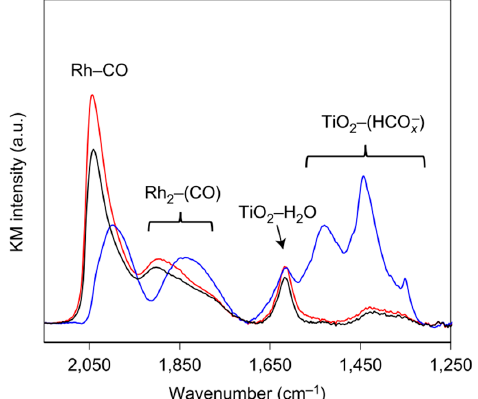
Figure 2. In situ DRIFT spectra collected from 2% Rh / TiO 2 at the reaction conditions (180 ◦ C, 1% CO 2 , 1% H 2 , 98 % He) for reduced ( red ), 20CO 2 :2H 2 treated ( blue ), re-reduce ( black ) catalysts. On 20CO 2 :2H 2 treatment, the CO stretching frequency of linear and bridge Rh-carbonyl groups decreased by 50 cm − 1 , their intensity dropped twofold and TiO 2 -bound HCO x species appeared. Re-reduction reversed all the effects of the 20CO 2 :2H 2 treatment. Reprinted with permission from Reference [33]. Copyright 2016, Springer Nature.